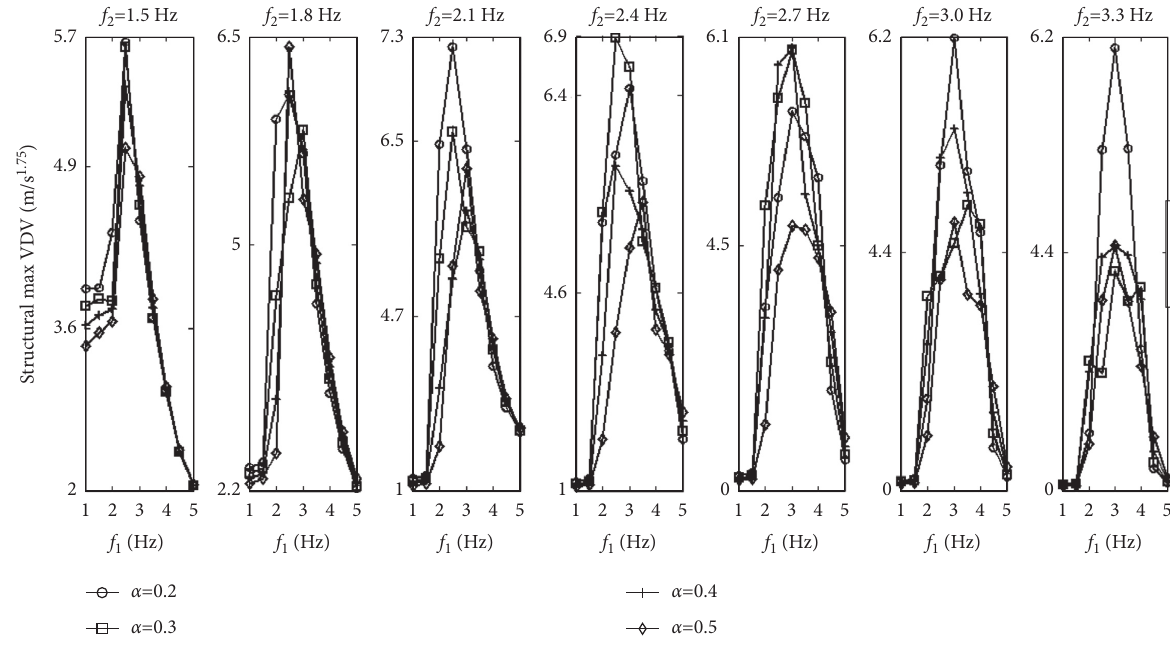
Figure 28: The results of model with different α when f Table 9: The max reduce amplitude of structural dynamic with α , ζ